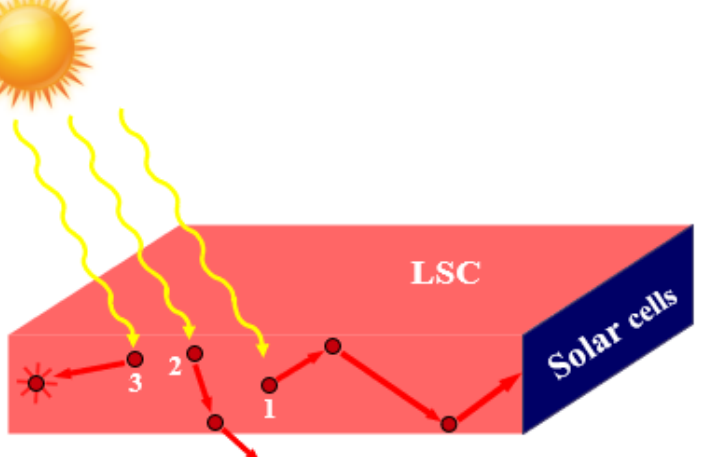
Figure 1. Graphical representation of an LSC panel. The semi-transparent slab is depicted in red, whereas the PV cells are schematized in blue. When a ray of light is absorbed by the dye of an LSC three phenomena can occur: (1) the fluorescence radiation is trapped inside the slab until is absorbed by the cell, (2) the re-emitted radiation is lost through the escape-cone and (3) the fluorescence radiation is absorbed by another dye molecule (self-absorption).